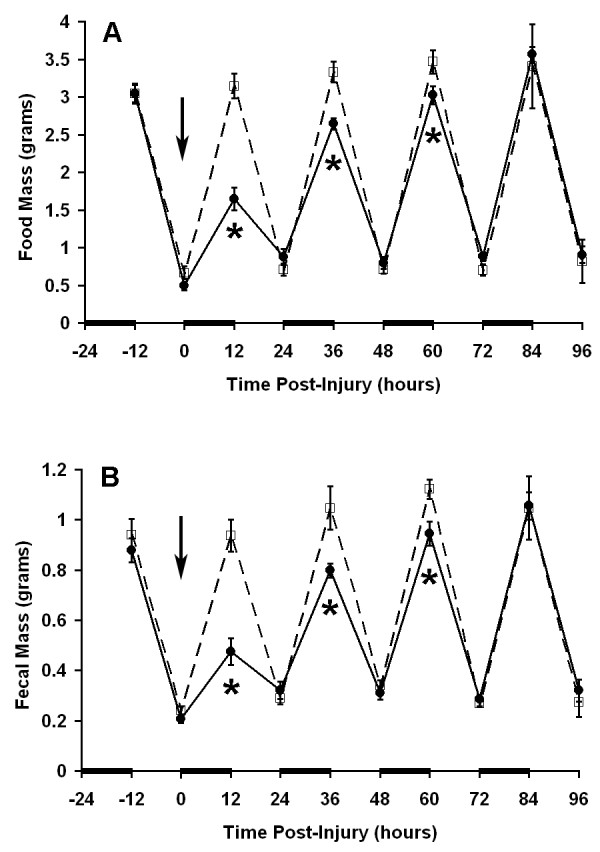
Induction of post-operative ileus. Twelve hour measurements are plotted as described in legend for Figure 2. Mice were anesthetized, a laparotomy performed, and the cecum manipulated with cotton tipped swabs for 1 minute at time 0 (solid line). Control mice received anesthesia for a similar time (dashed line). N = 10 mice per group. * P = 0.008 vs. control at corresponding time point.